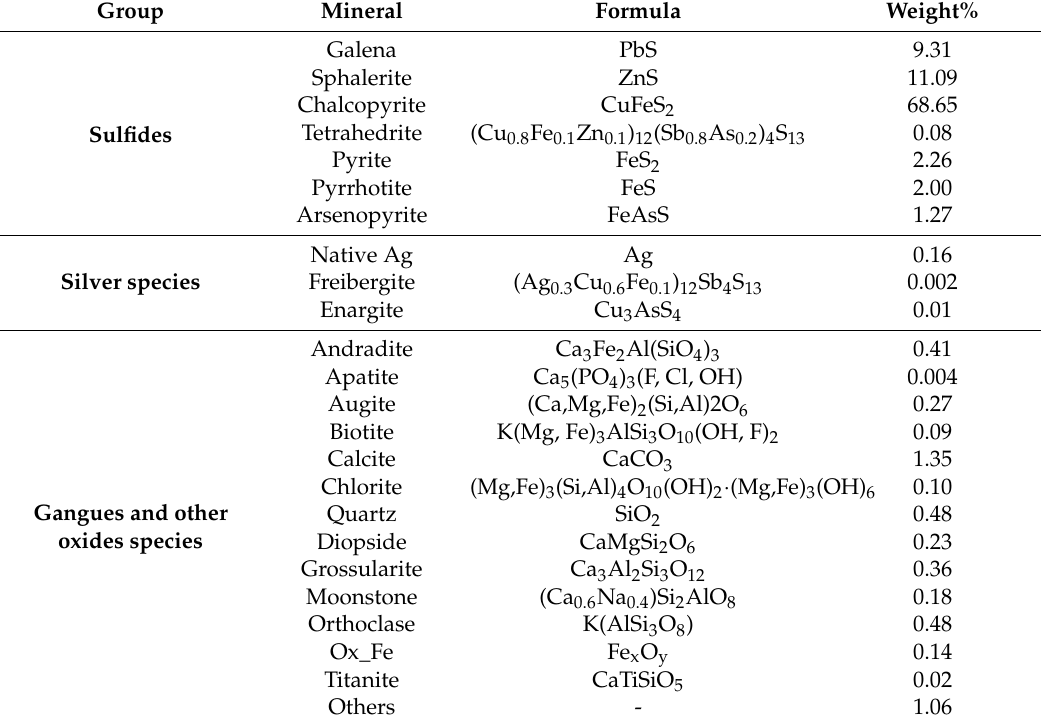
Table 4. Results of the analysis of the chalcopyrite concentrate by the SEM-BSE system.